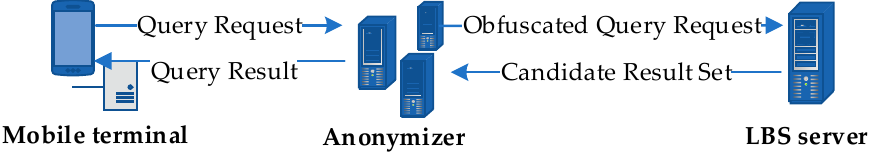
Figure 1. The centralized architecture.